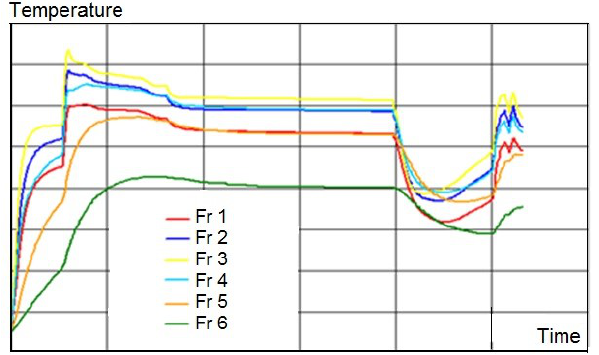
Figure 5: The graphs of temperature versus time in the individual fragments of the